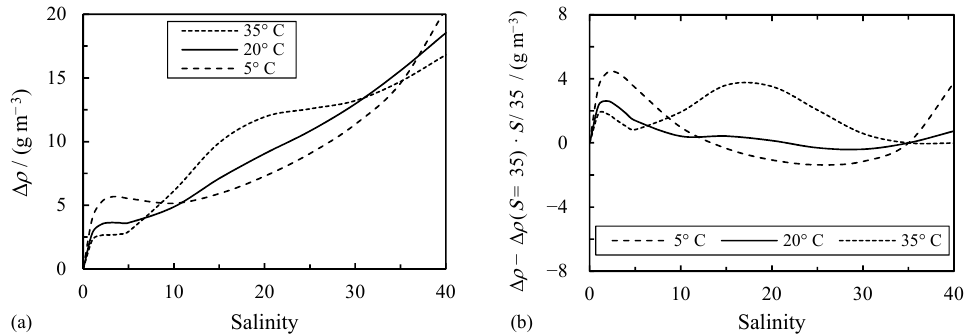
Figure 11. Density deviation of TEOS-10 from the density–salinity relation (i.e. TEOS-10 minus DSR) for degassed seawater at selected temperatures and atmospheric pressure. (a) The deviation (cid:49)ρ increases linearly with salinity. The uncertainty in the deviation is 8gm − 3 , and is significantly exceeded at salinities higher than 20. (b) By contrast, the salinity-35-reduced deviation is less than 5gm − 3 .